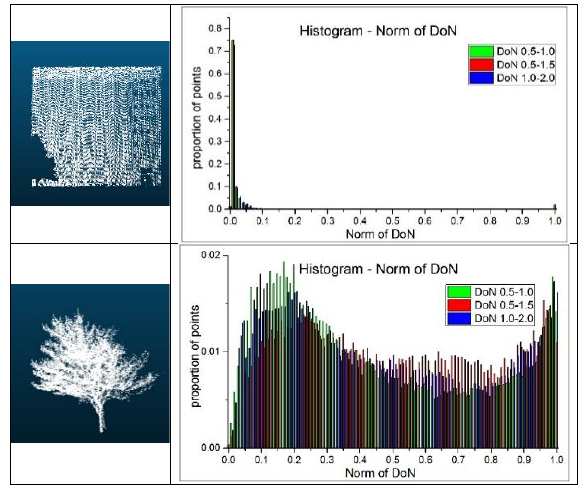
Figure 3. Histogram of the norm of DoN for distinguishing different